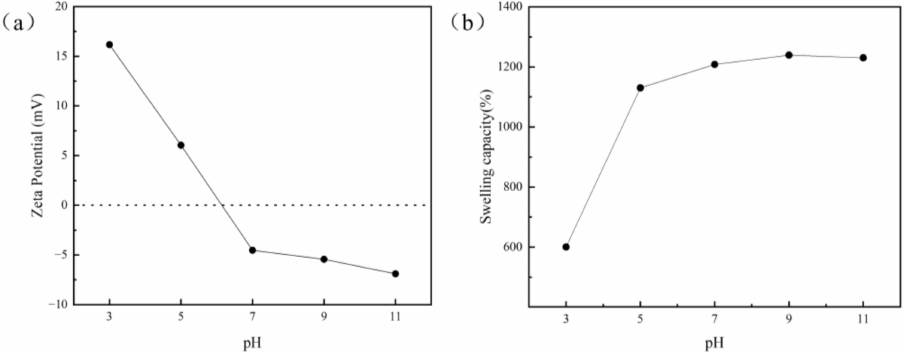
Figure 6. ( a ) Zeta potential of GO − ATP@CS − PVA at different pH values; ( b ) Effect of pH on GO − ATP@CS − PVA swelling